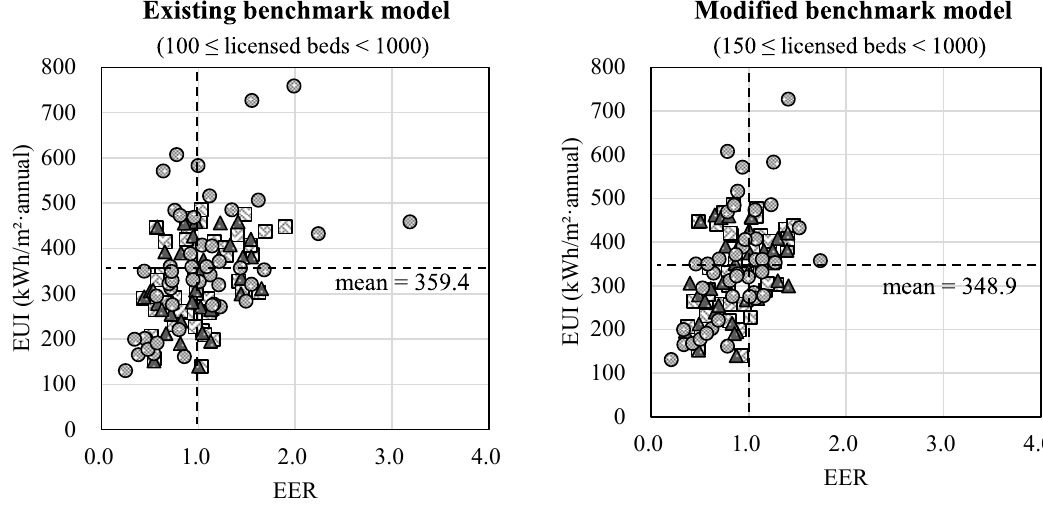
Figure 5. EER and EUI relationship according to the benchmark model.